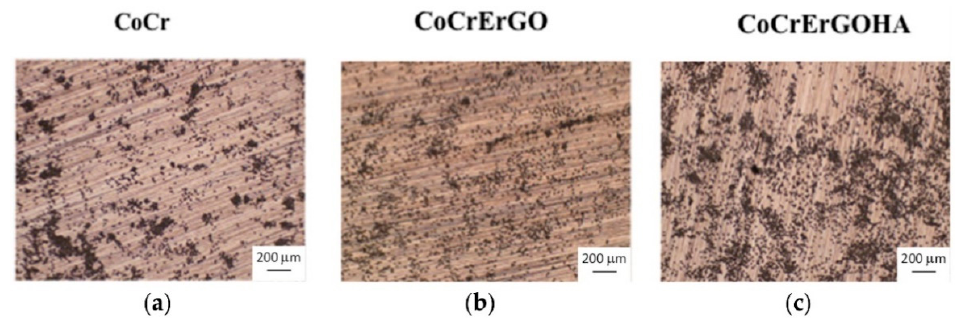
Figure 24. Following 72 h of cultivation, the pattern dispersion of the macrophage J774A.1 on the ( a ) CoCr, ( b ) CoCrErGO, and ( c ) CoCrErGOHA discs can be seen using optical imaging. Reprinted with permission from [138]. Copyright 2021 MDPI. Distributed under Creative Commons Attribution-based license (CCBY 4.0.).